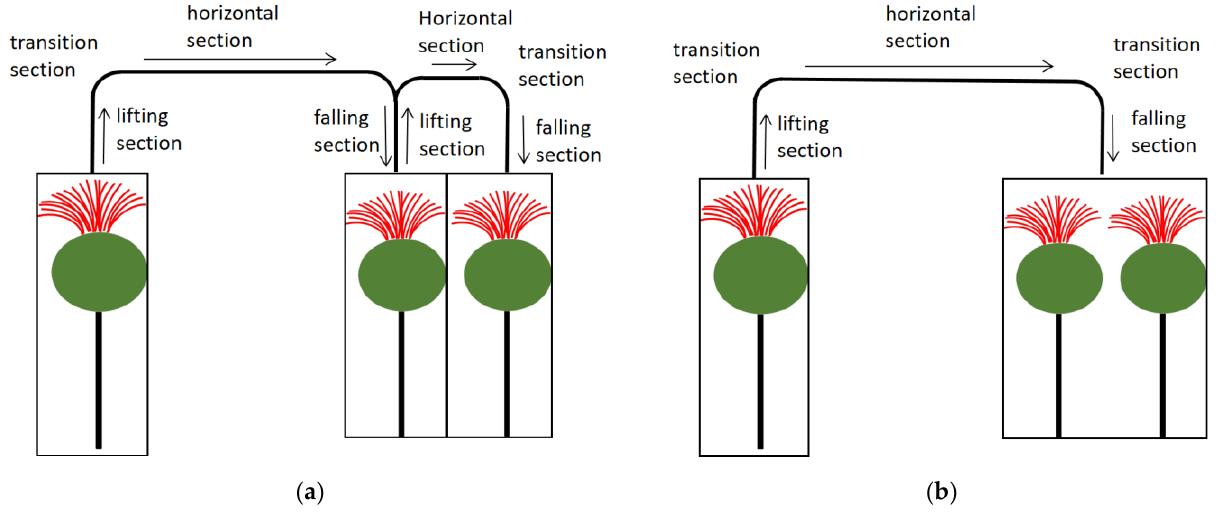
Figure 8. Secondary path optimization effect: ( a ) initial path planning; ( b ) secondary path optimi- zation.